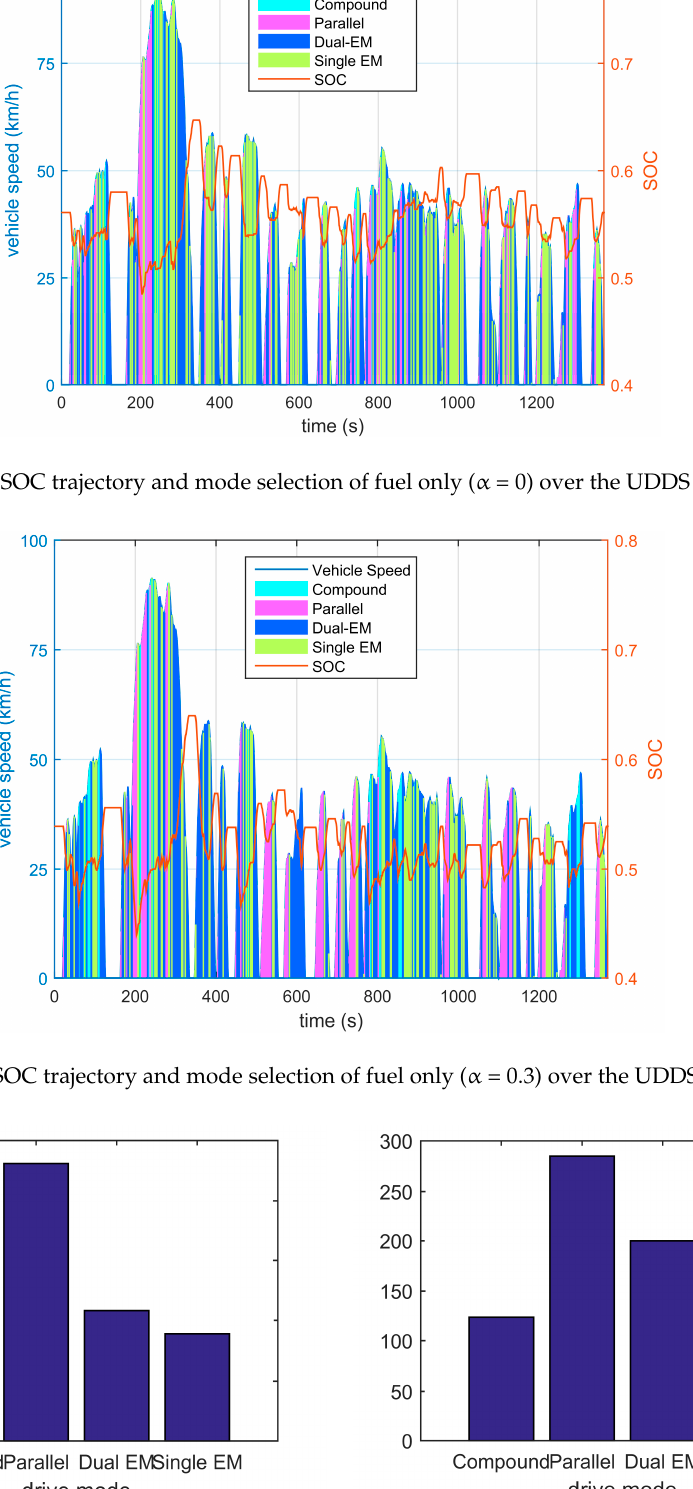
Figure 9. ( a ) Active Drive mode in fuel-economy optimization ( α = 0); and ( b ) Active Drive mode in multi-objective optimization ( α = 0.3).